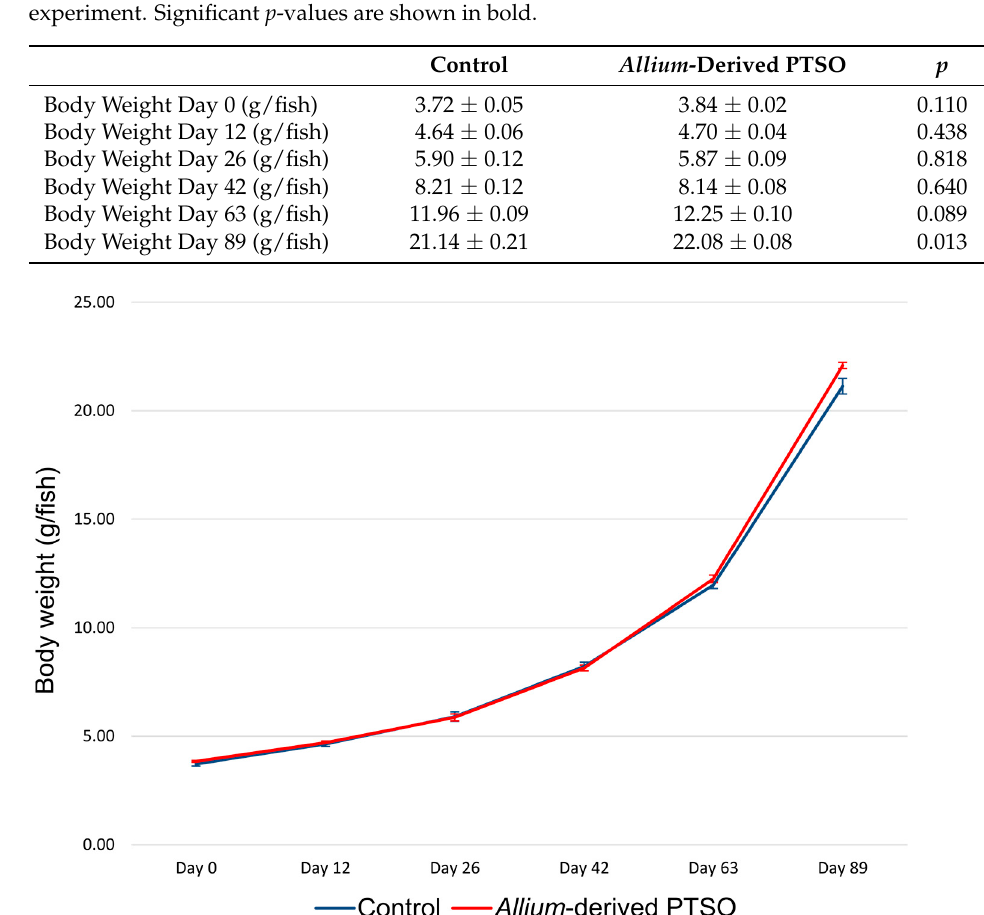
Figure 1. Evolution of growth performance of European seabass ( D. labrax ) juveniles fed with control diet or supplemented with Allium -derived PTSO along the feeding trial. Error bars show standard